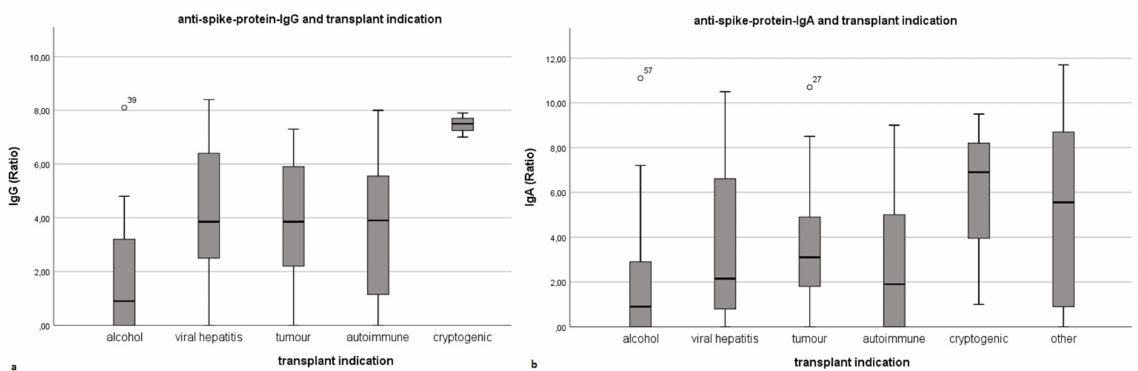
Figure 4. Influence of transplant indication on anti-spike-protein-IgG- and IgA-levels as box plots. ( a , b ) show the significant influence of the underlying disease on anti-spike-protein-IgG- and IgA-levels. Ratio = dimensionless unit; quotient of the extinction value of the patient sample and the calibrator. Box plots present means, interquartile range (IQR), minimum and maximum with each individual